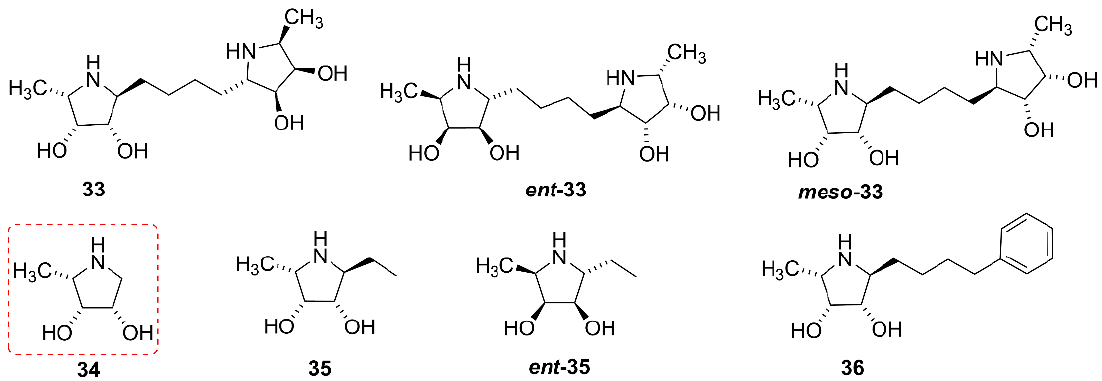
Figure 5 . Structures of divalent inhibitors and the corresponding monomers by Behr.